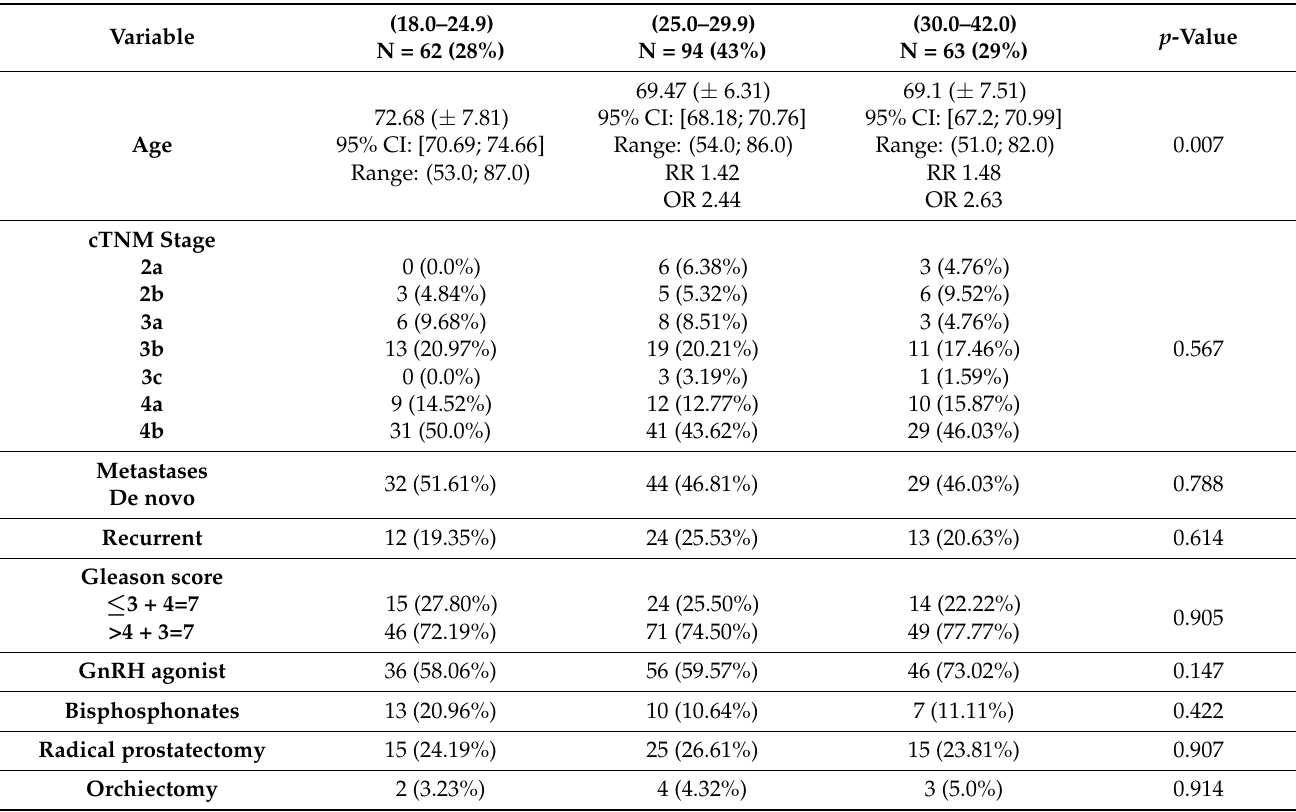
Table 1. Patient clinical characteristics.